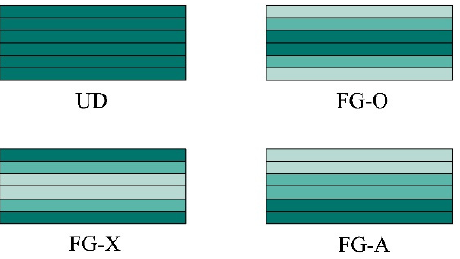
Figure 2. Different distribution modes of graphene nanoplatelets (GPLs).